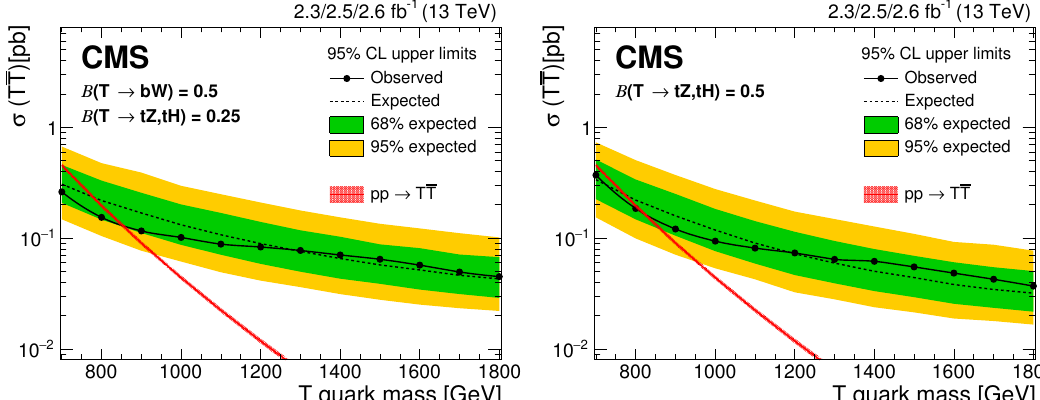
Figure 12 . The expected and observed upper limits (Bayesian) at 95% CL on the cross section of TT production for the singlet benchmark (left) and the doublet benchmark (right) after combining the boosted W and boosted H channels. The theoretically predicted cross section for TT production calculated at NNLO is shown as red line, with the uncertainties in the PDFs and renormalization and factorization scales indicated by the shaded area. Masses below 700 GeV were excluded